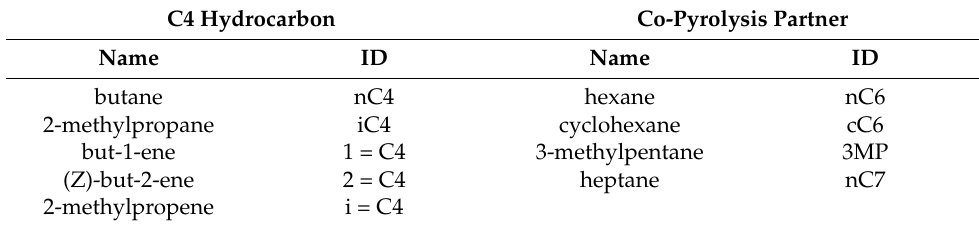
Table 1. List of studied C4 hydrocarbons and C6+ co-pyrolysis partners with their abbreviations. C4